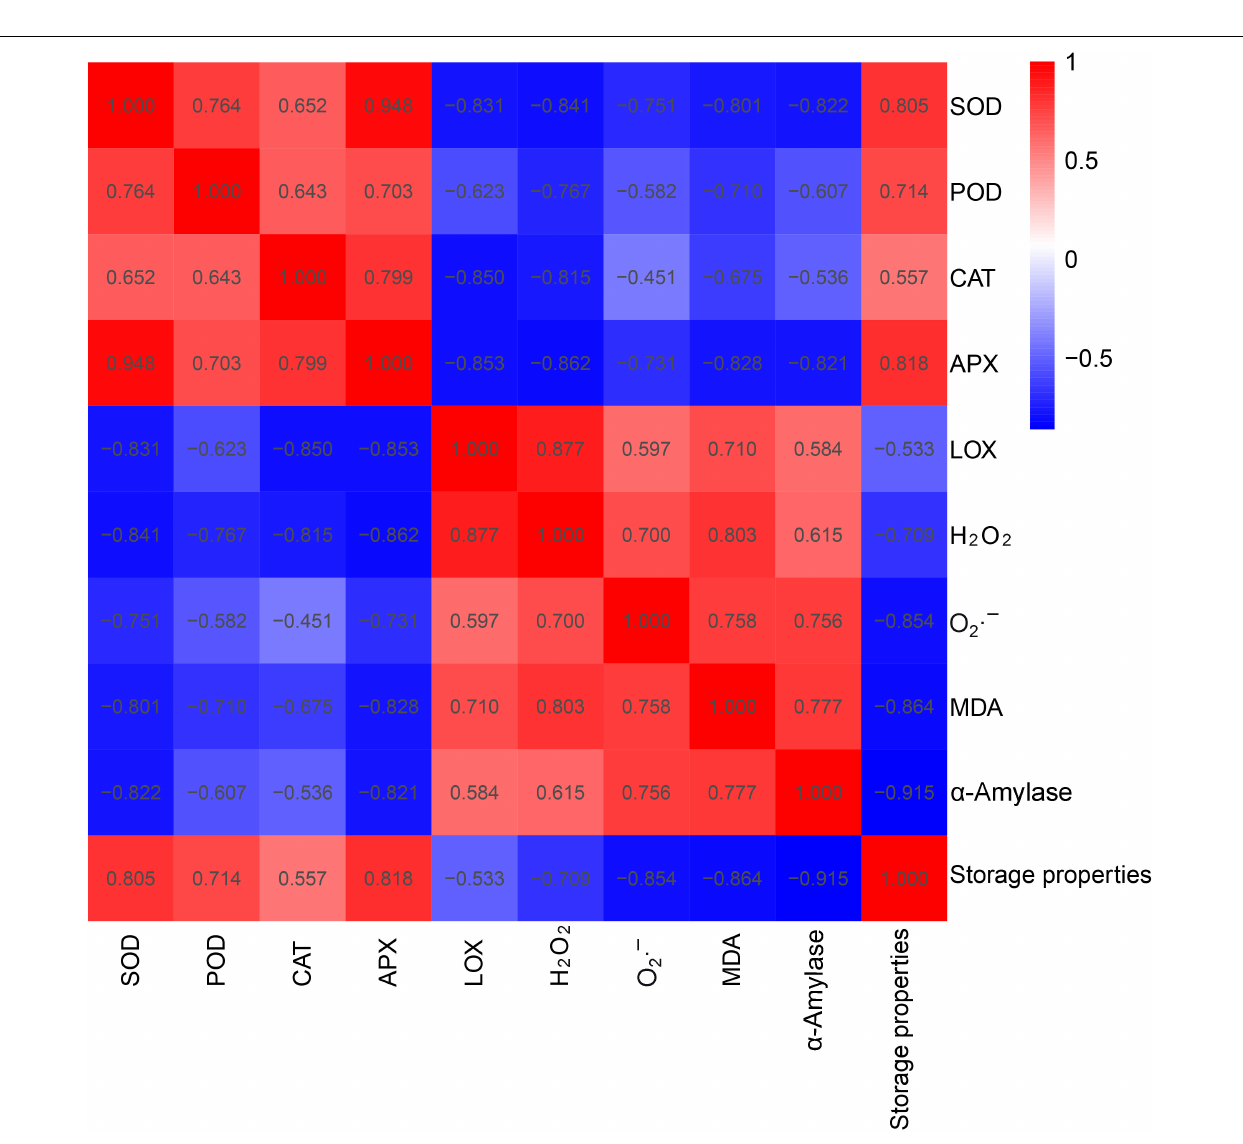
FIGURE 5 | Correlation analysis among SOD, POD, APX, CAT, and LOX activities, superoxide anion (O 2 · − ) production, and MDA and H 2 O 2 contents in the leaves and storage property and α -amylase in the roots of 10 sweet potato cultivars (i.e., Xu 32, Xu 55-2, Z15-1, Shangshu 19, Sushu 16, Yanshu 5, Hanzi, Yushu, Zhezi 3, and Yan